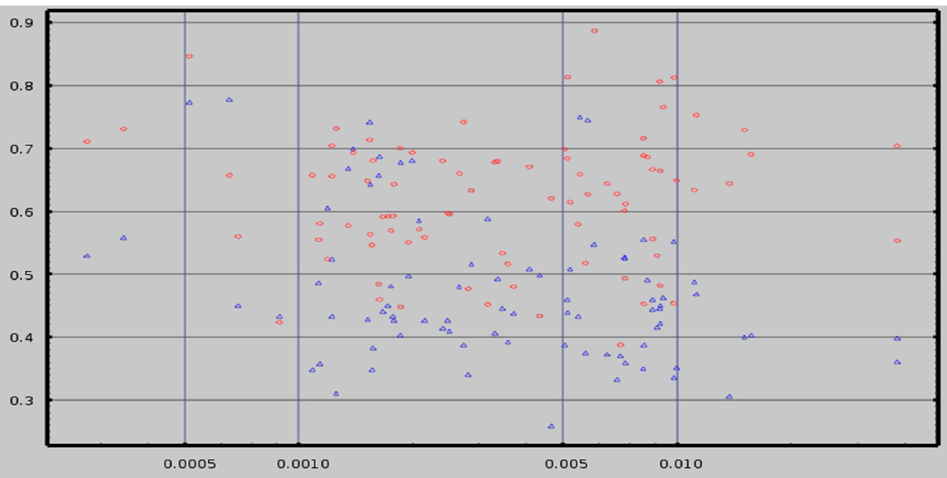
Figure 10. The correlations between measures for empty room and human resting for 85 cortical and subcortical regions for the CamCAN (blue, n = 619) and the TEAM-TBI (red, n = 63) cohorts are plotted on the y-axis. The number of events found within each region as a fraction of the total number of events found is plotted on the x-axis; the x-axis is logarithmic. The correlations are greater for TEAM-TBI than CamCAN as expected given the large difference in the n values. See text for details.